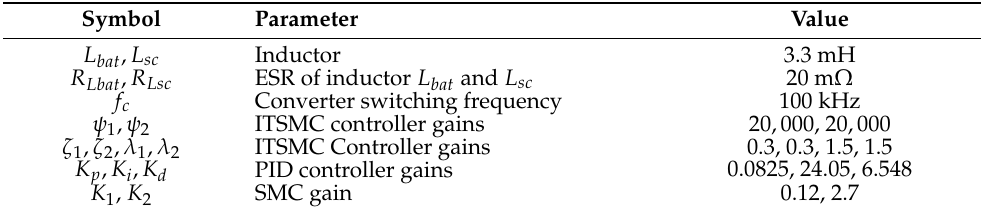
Table 3. Parameters of DC–DC converters and controllers. ESR: equivalent series resistance; ITSMC: integral terminal sliding mode controller; PID: proportional–integral–derivative; SMC: sliding mode